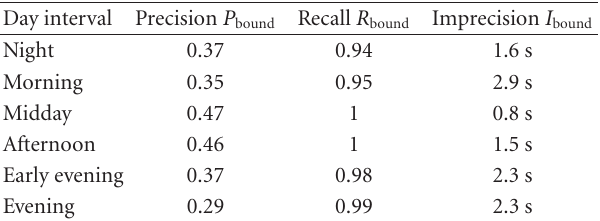
Table 5: Evaluation of the TV stream segmentation on TVTest